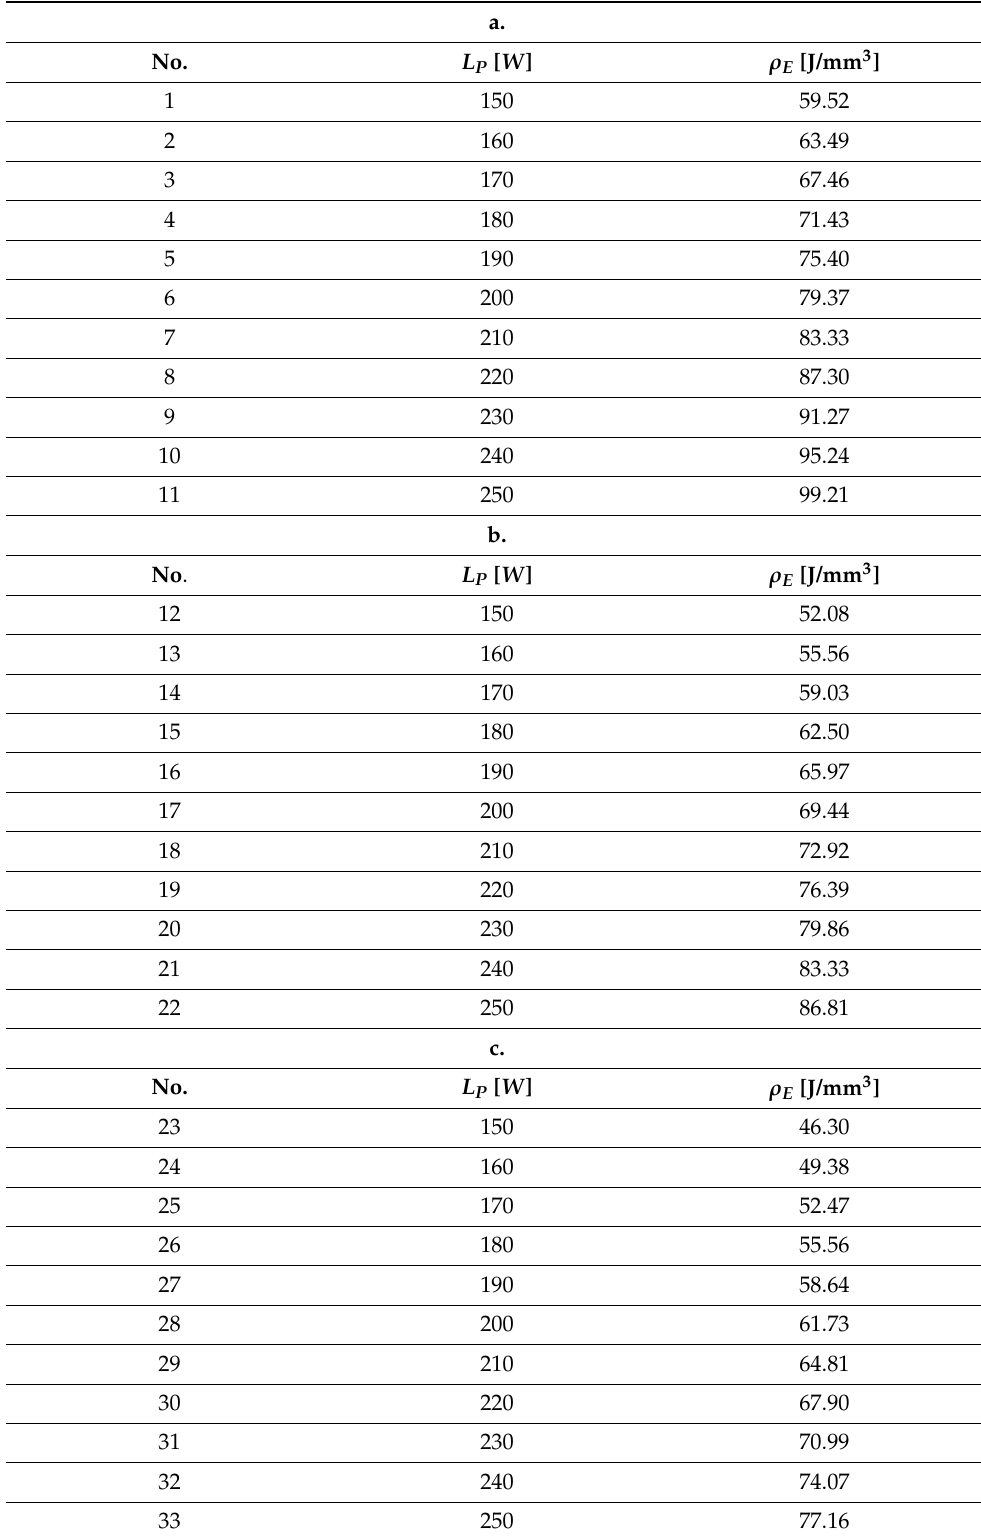
Table 1. a. Sets of analyzed process parameters for exposure velocity equal to 700 mm/s. b. Sets of analyzed process parameters for exposure velocity equal to 800 mm/s. c. Sets of analyzed process parameters for exposure velocity equal to 900 mm/s.